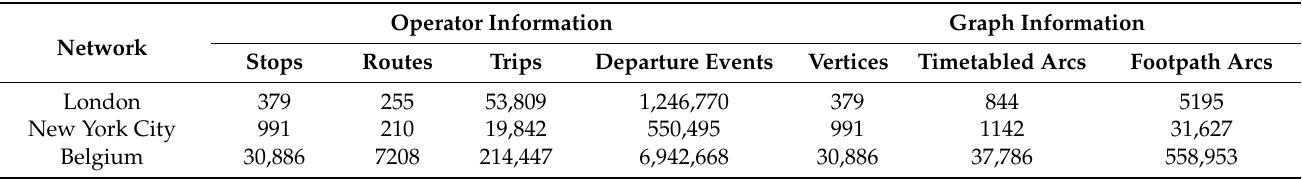
Table 1. Networks employed in the experiments.